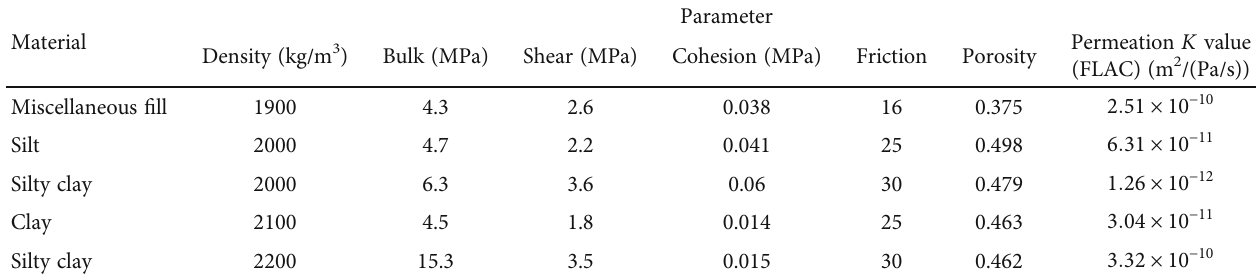
Table 2: Soil physical